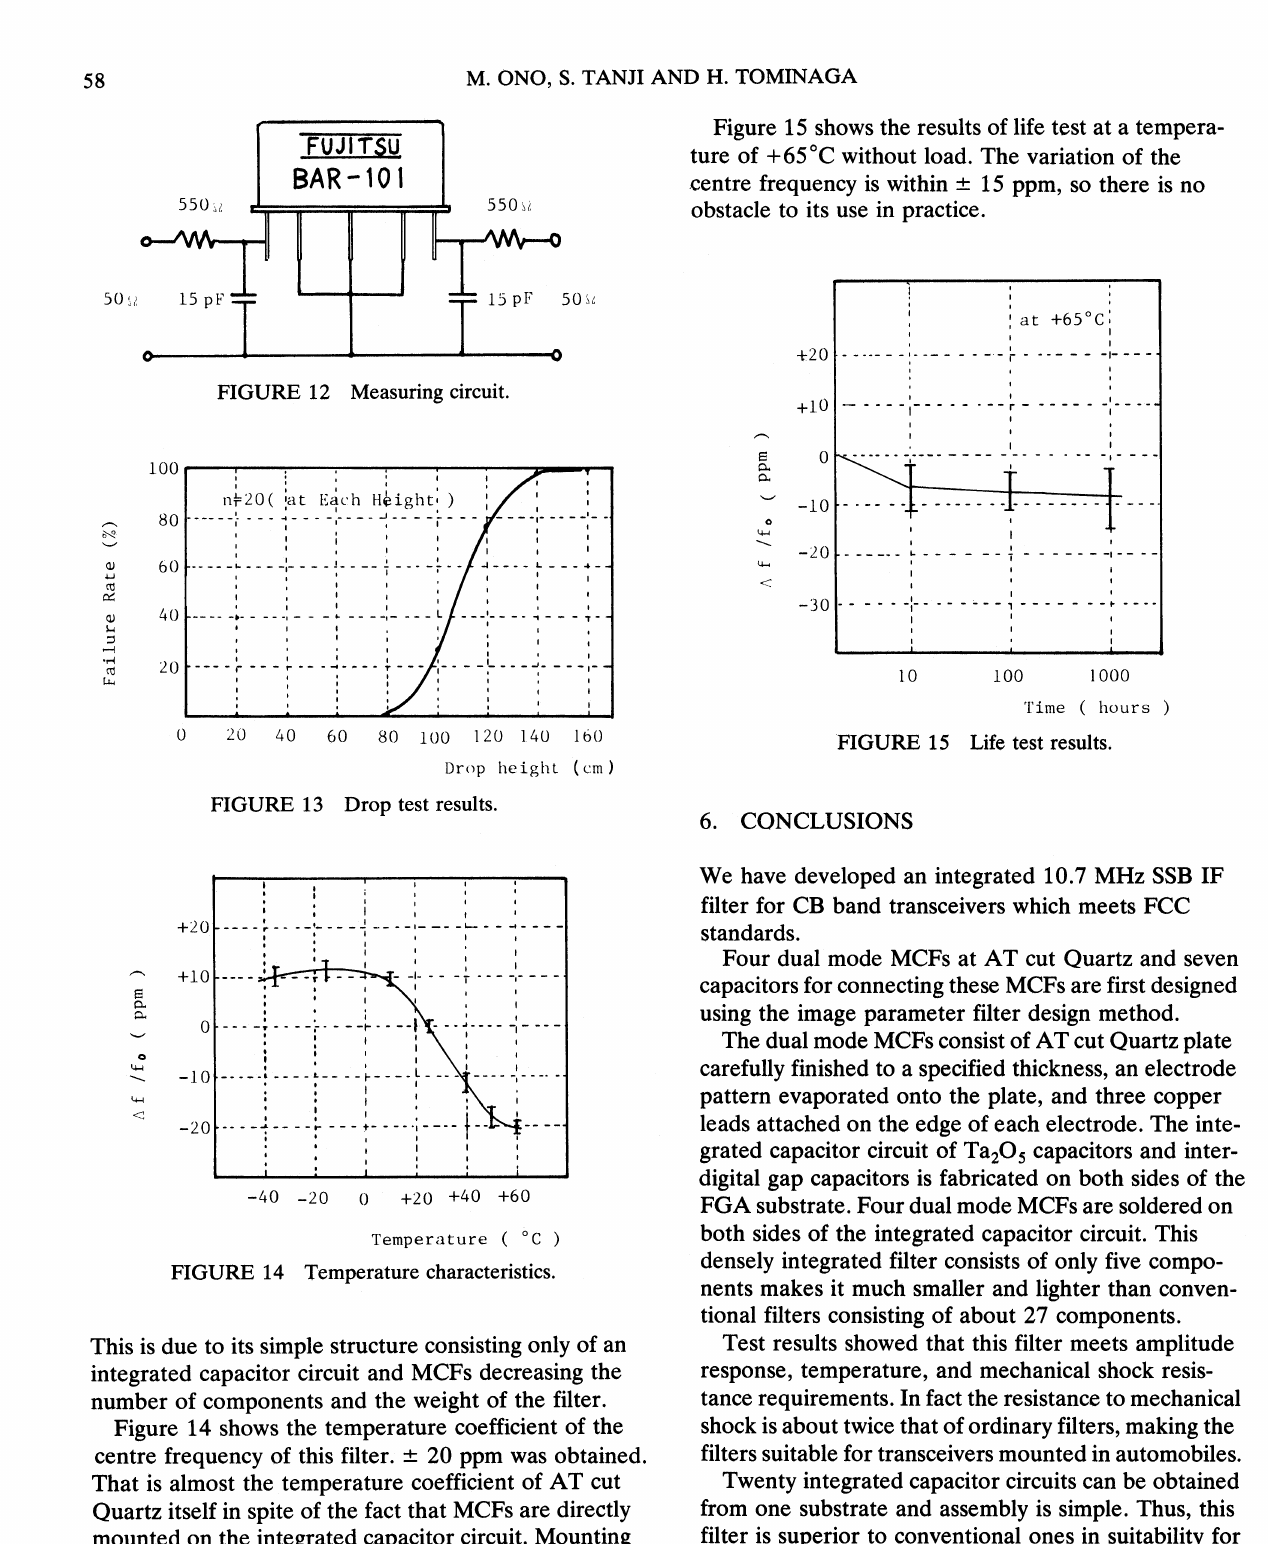
FIGURE 14 Temperature